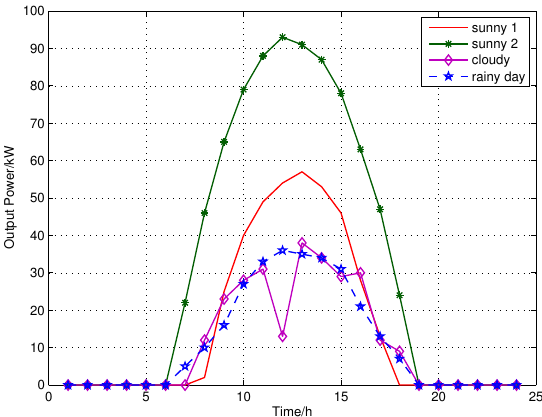
Figure 5. The solar power for different weather